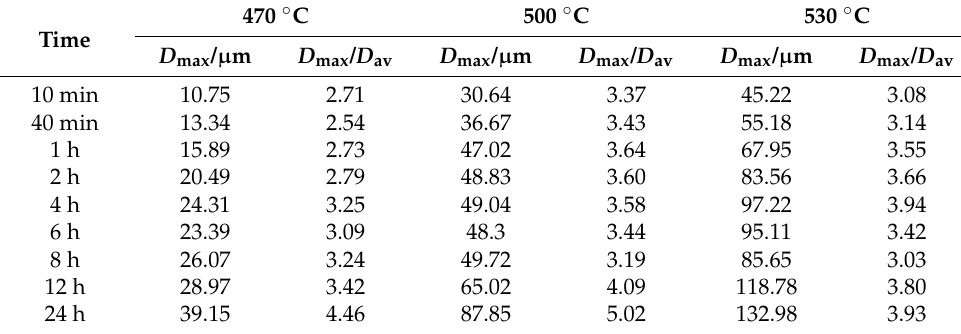
Table 3. The D max and D max / D av for different heat treatment